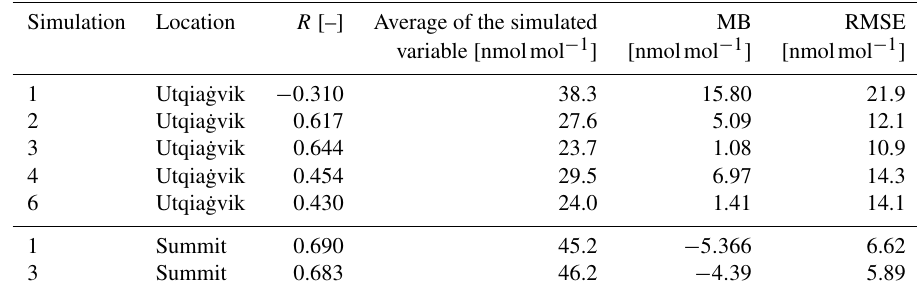
Figure 5. Correlation of observed and modeled ozone at Utqia˙gvik for the complete time range of 1 February through 1 May 2009. The black and blue lines show perfect agreement and the regression line of simulation and observation, respectively. Table 4. Statistics at Utqia˙gvik and Summit for the ozone mixing ratio for 1 February through 1 May